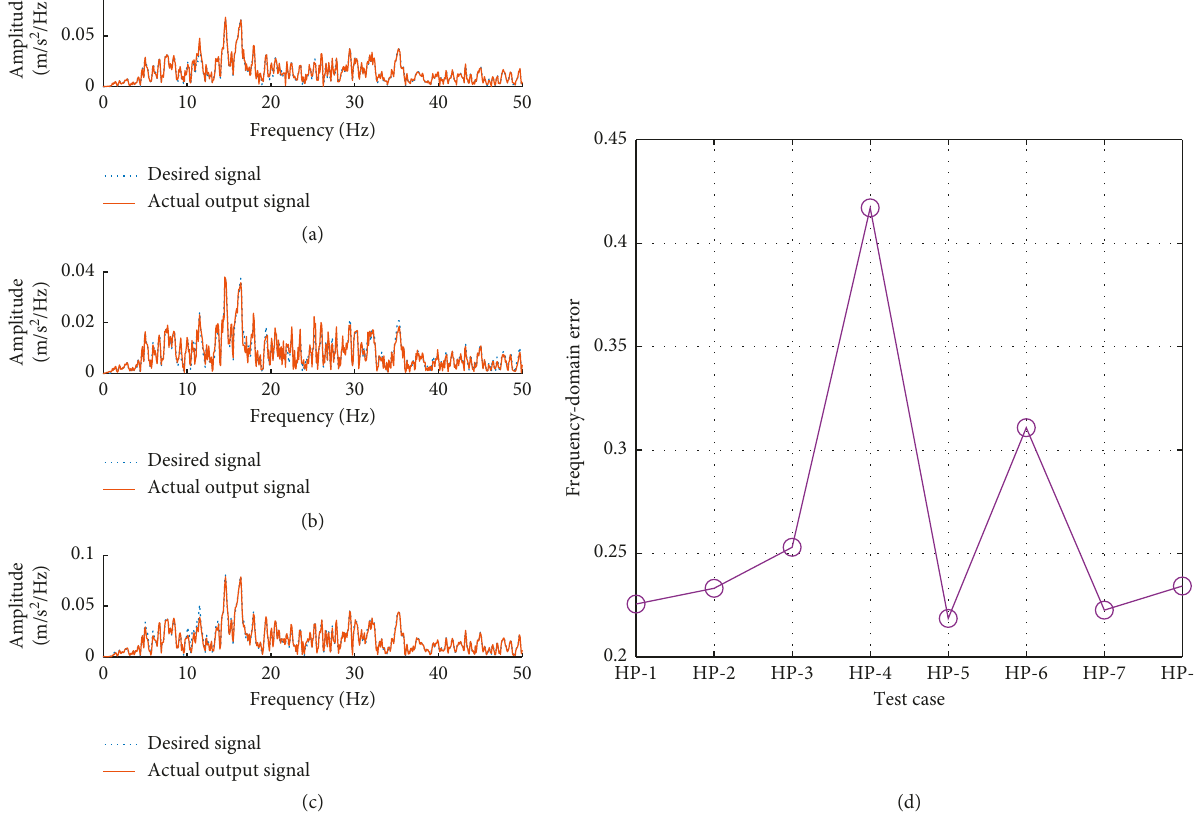
Figure 20: Desired signal and actual output signal frequency-domain comparison and error. (a) Case HP-1; (b) case HP-3; (c) case HP-5; (d) frequency-domain error of test cases.